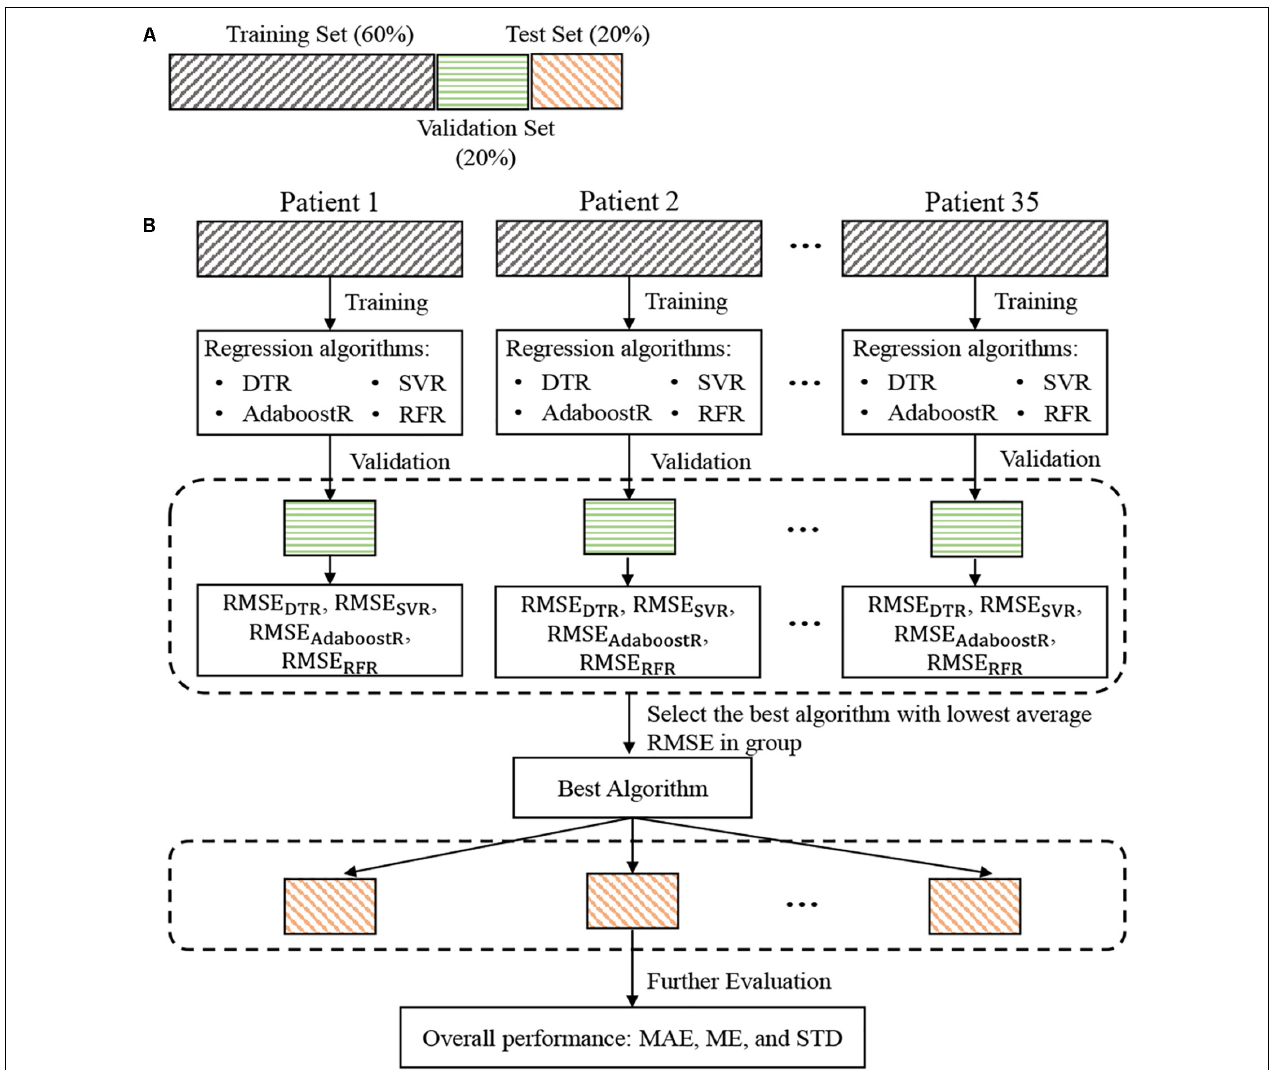
FIGURE 3 | Dataset partition for each patient (A) and flowchart of blood pressure estimation model construction and evaluation (B) . RMSE DTR , RMSE SVR , RMSE AdaboostR , and RMSE RFR represents the root mean square error between the reference and the estimated blood pressure values by the DTR, SVR, AdaboostR, and RFR, respectively. RMSE, root-mean-square error; DTR, decision tree regression; SVR, support vector machine regression; AdaboostR, adaptive boosting regression; RFR, random forest